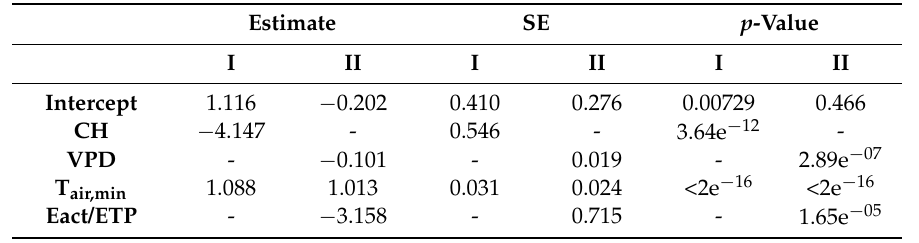
Table 4. Statistics of the multiple linear regression model developed using a forward stepwise-based selection procedure and quantile regression analyses for predicting T c,min (= minimum daily